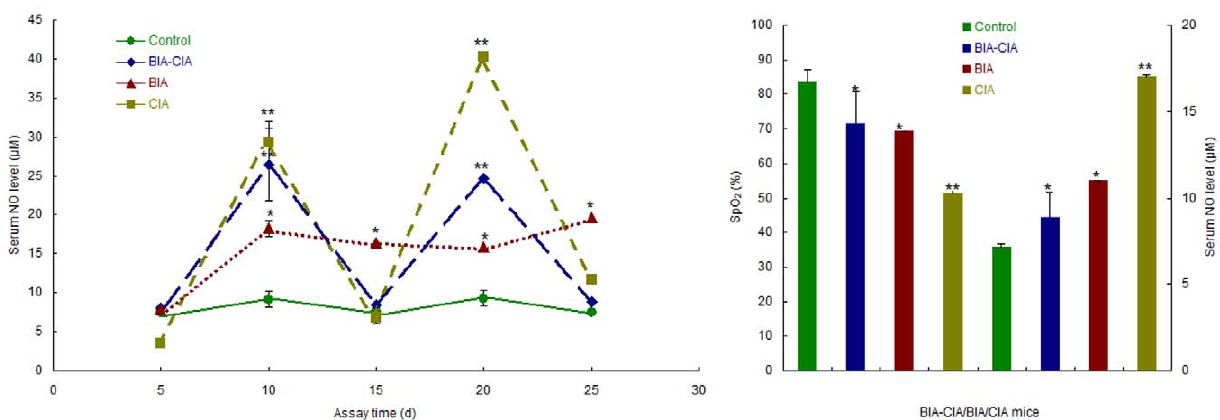
Figure 4. Dynamic monitoring of NO production and comparative analysis of relationship between NO and SpO 2 in BIA, CIA and BIA-CIA mice. A. Time-course detection of serum NO levels in BIA, CIA and BIA-CIA mice ( n =3). Sampling and detection were conducted every 5 d and until 25 d during modeling; B. Measurement of SpO 2 and NO in BIA, CIA and BIA-CIA mice ( n =4). Sampling and detection were conducted after modeling for 3 d in CIA and BIA-CIA mice or after modeling for 28 d in BIA mice. The singular asterisk (*) represents statistically significant difference from the control ( P , 0.05); and double asterisks (**) indicate statistically very significant difference from the control ( P , 0.01).